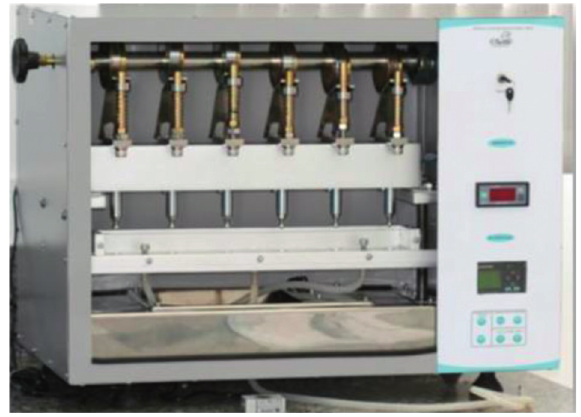
Figure 3: Electromechanical mastication fatigue testing equipment.